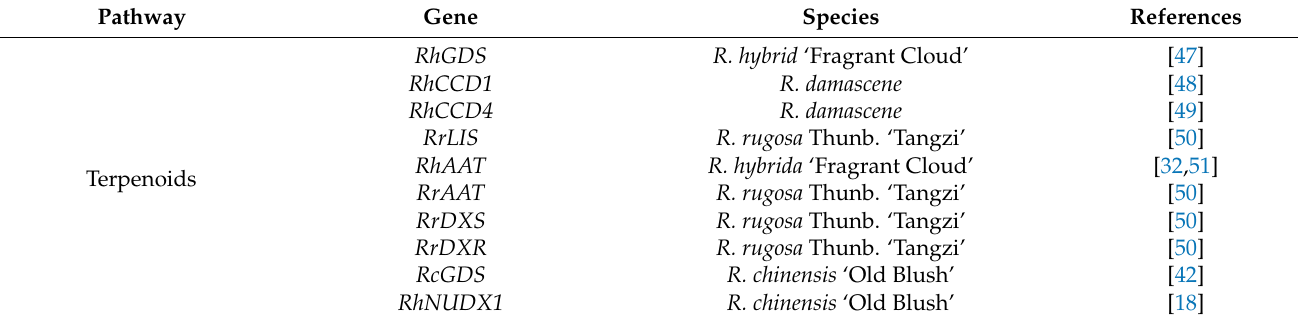
Table 2. Scent-related genes in